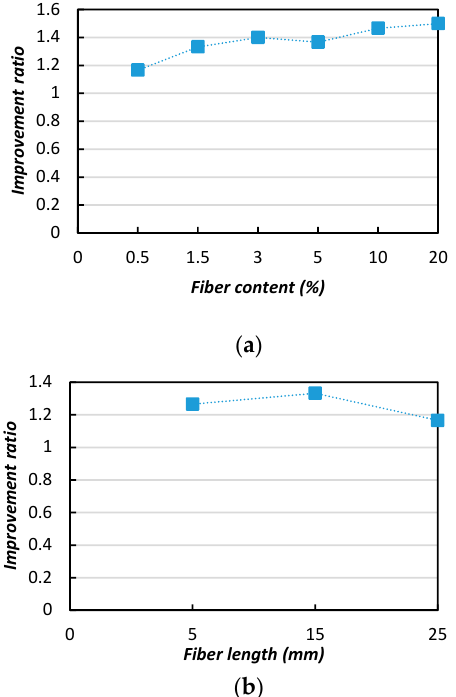
Figure 14. Improvement ratios for bacterial immobilization with the addition of jute fibers: ( a ) fiber content; ( b ) fiber length.